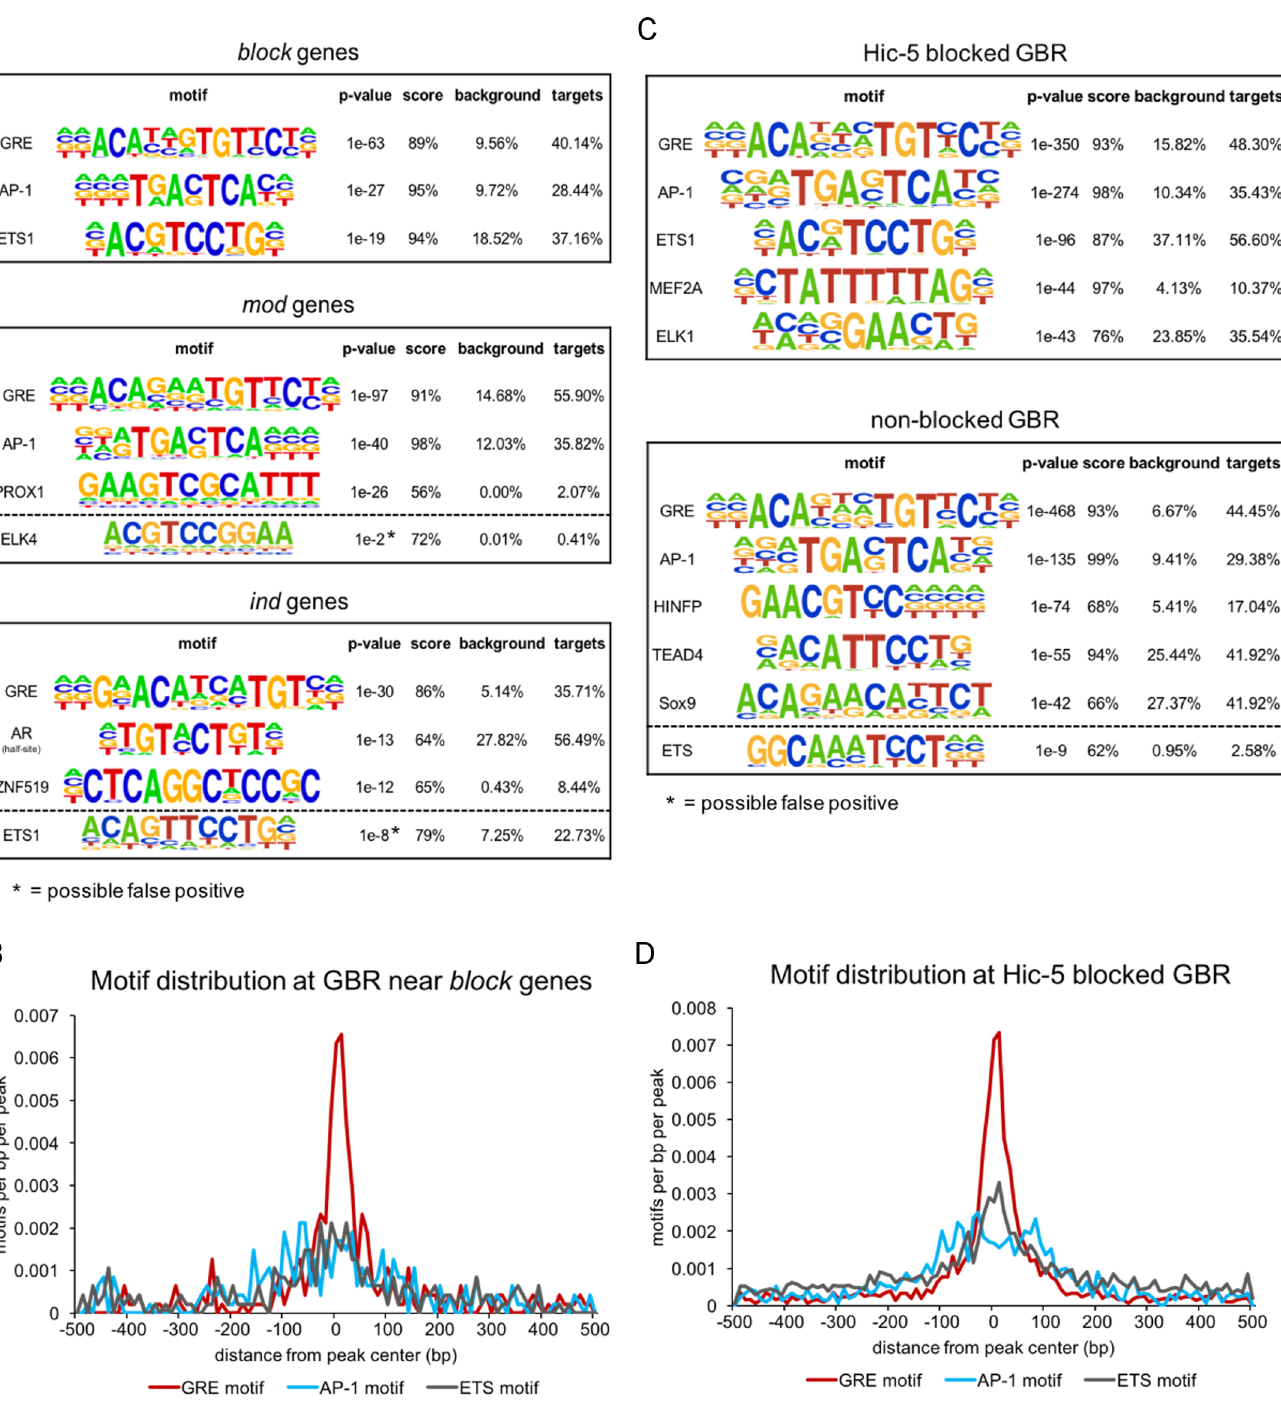
Fig 5. ETS motif is enriched at Hic-5 blocked GBR and GBR near the block genes. (A) ETS motif is enriched in GBR near block genes but not in GBR near mod and ind genes. De novo motif analysis was performed using HOMER; the top 3 ranked motifs are shown with their p-value, score for concordance of the de novo motif with the identified match, and prevalence near the GBR set examined. Motif analysis was performed in a 1-kb window centered on the GBR peak for all GBR within 100 kb of the TSS of the block , mod and ind genes. Motifs below the dotted lines are for the highest scoring member of the ETS family (shown for comparison to the block genes), which were not found as one of the top three motifs for mod and ind genes and indicated as possible false positives by HOMER. (B) GR, AP-1 and ETS motif distribution in a 1-kb window centered on the peak of all GBR near the block genes. Red, GRE motif; blue, AP-1 motif; black, ETS motif. (C) ETS motif is enriched at Hic-5 blocked GBR but not at non-blocked GBR. Motif analysis was performed, as in A, for all Hic-5 blocked and non-blocked GBR. The top 5 motifs are shown. ETS motif below the dotted line is shown for comparison, but was not one of the top 5 motifs and was indicated as a possible false positive by HOMER. (D) GR, AP-1 and ETS motif distribution near Hic-5 blocked GBR, presented as in B. https://doi.org/10.1371/journal.pone.0196965.g005 PLOS ONE | https://doi.org/10.1371/journal.pone.0196965 May 8,